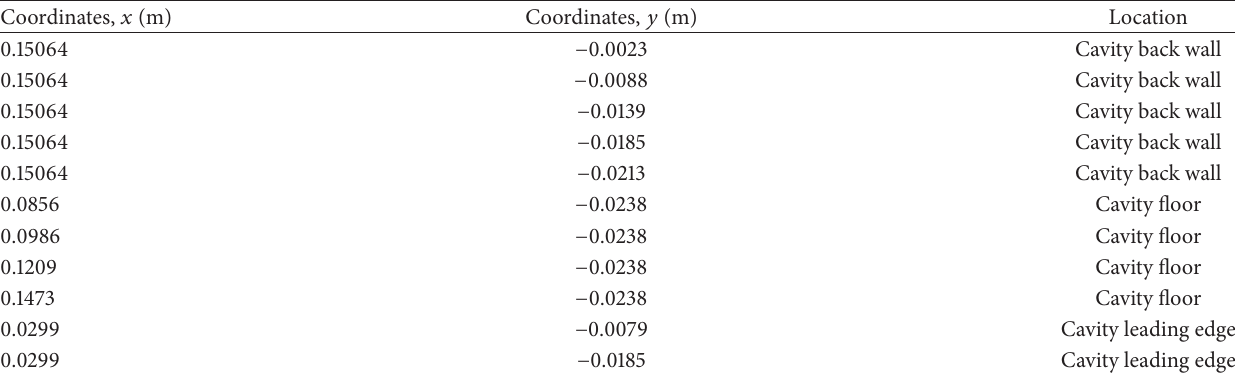
Table 5: Number of modes and energy content with locations corresponding to minimum and maximum points of modes. Coordinates, 𝑥